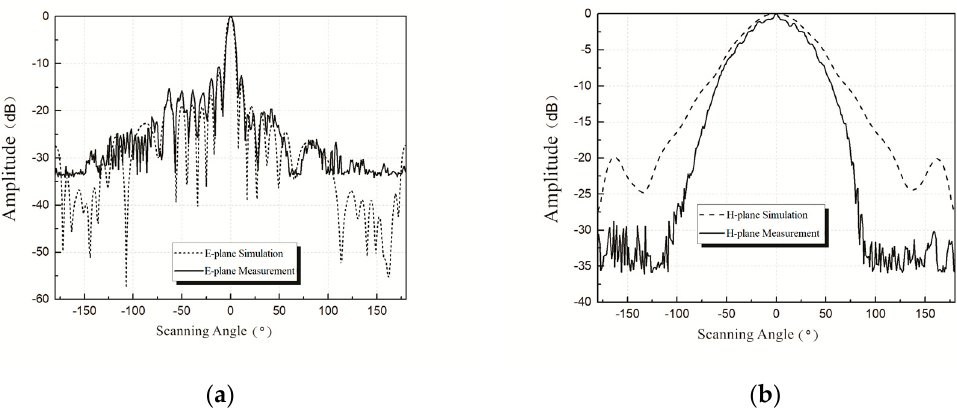
Figure 9. ( a ) Simulation and measurement results on E -plane of "1111111111" patch array antenna; ( b ) simulation and measurement results on H -plane of "1111111111" patch array antenna.